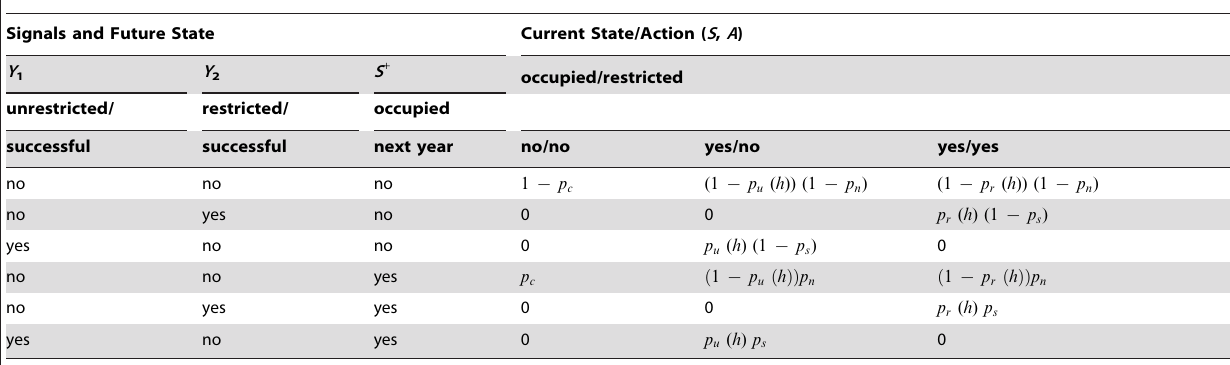
Table 1. Individual site joint state/signal probability matrix.